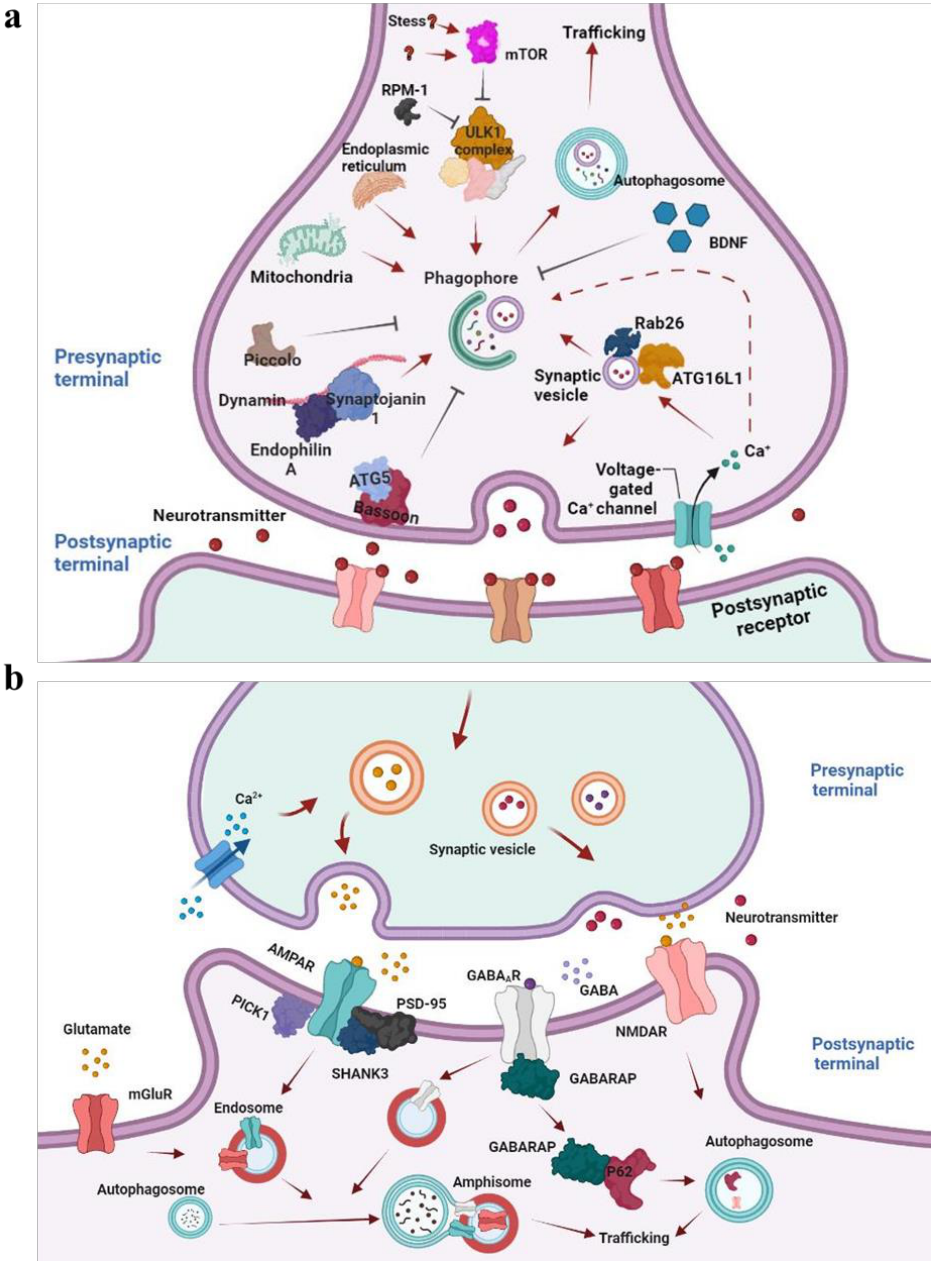
Figure 8. The cross-regulation between neuronal autophagy and synaptic vesicles at the pre-synap- tic and post-synaptic terminals. Neuronal activity induces autophagosome formation at the presyn- aptic terminal by regulating several presynaptically enriched adaptors (such as Synaptojanin1, En- dophilin A, and Bassoon) and regulatory proteins ( a ). At the postsynaptic terminal, neuronal activity also upregulates neuronal autophagy, resulting in endocytic removal of neurotransmitter recep- tors (such as GABAAR, NMDAR, and AMPAR) from the plasma membrane, presumably by mod- ulating receptor adaptor proteins ( b ).